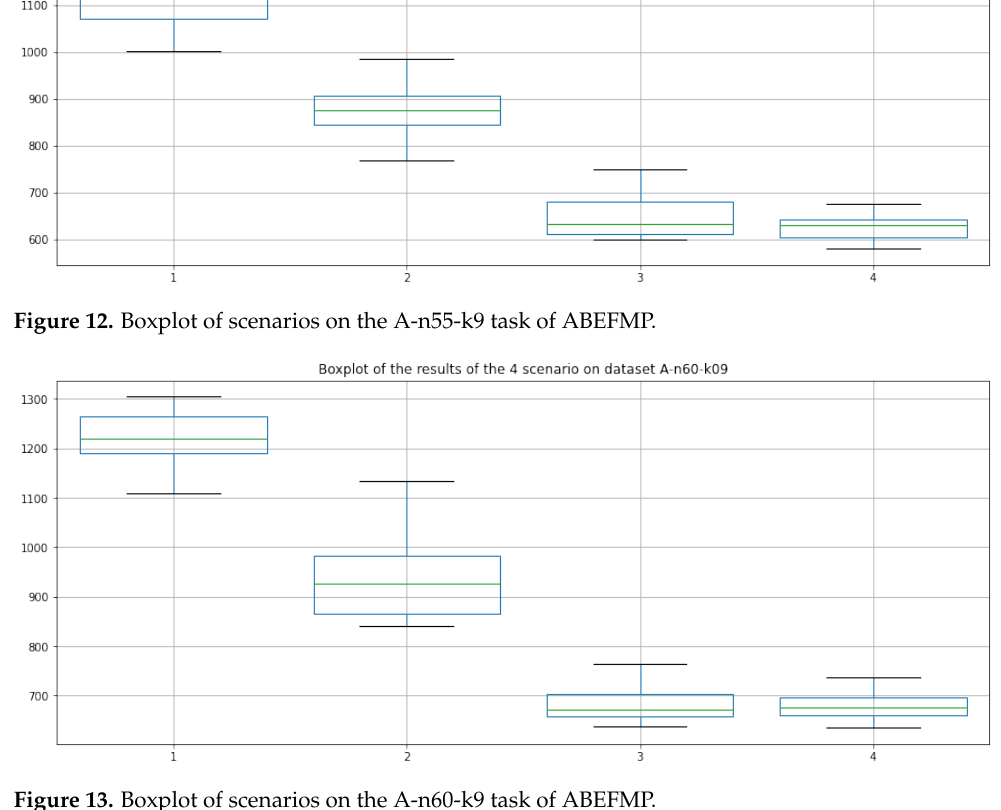
Figure 13. Boxplot of scenarios on the A-n60-k9 task of ABEFMP.